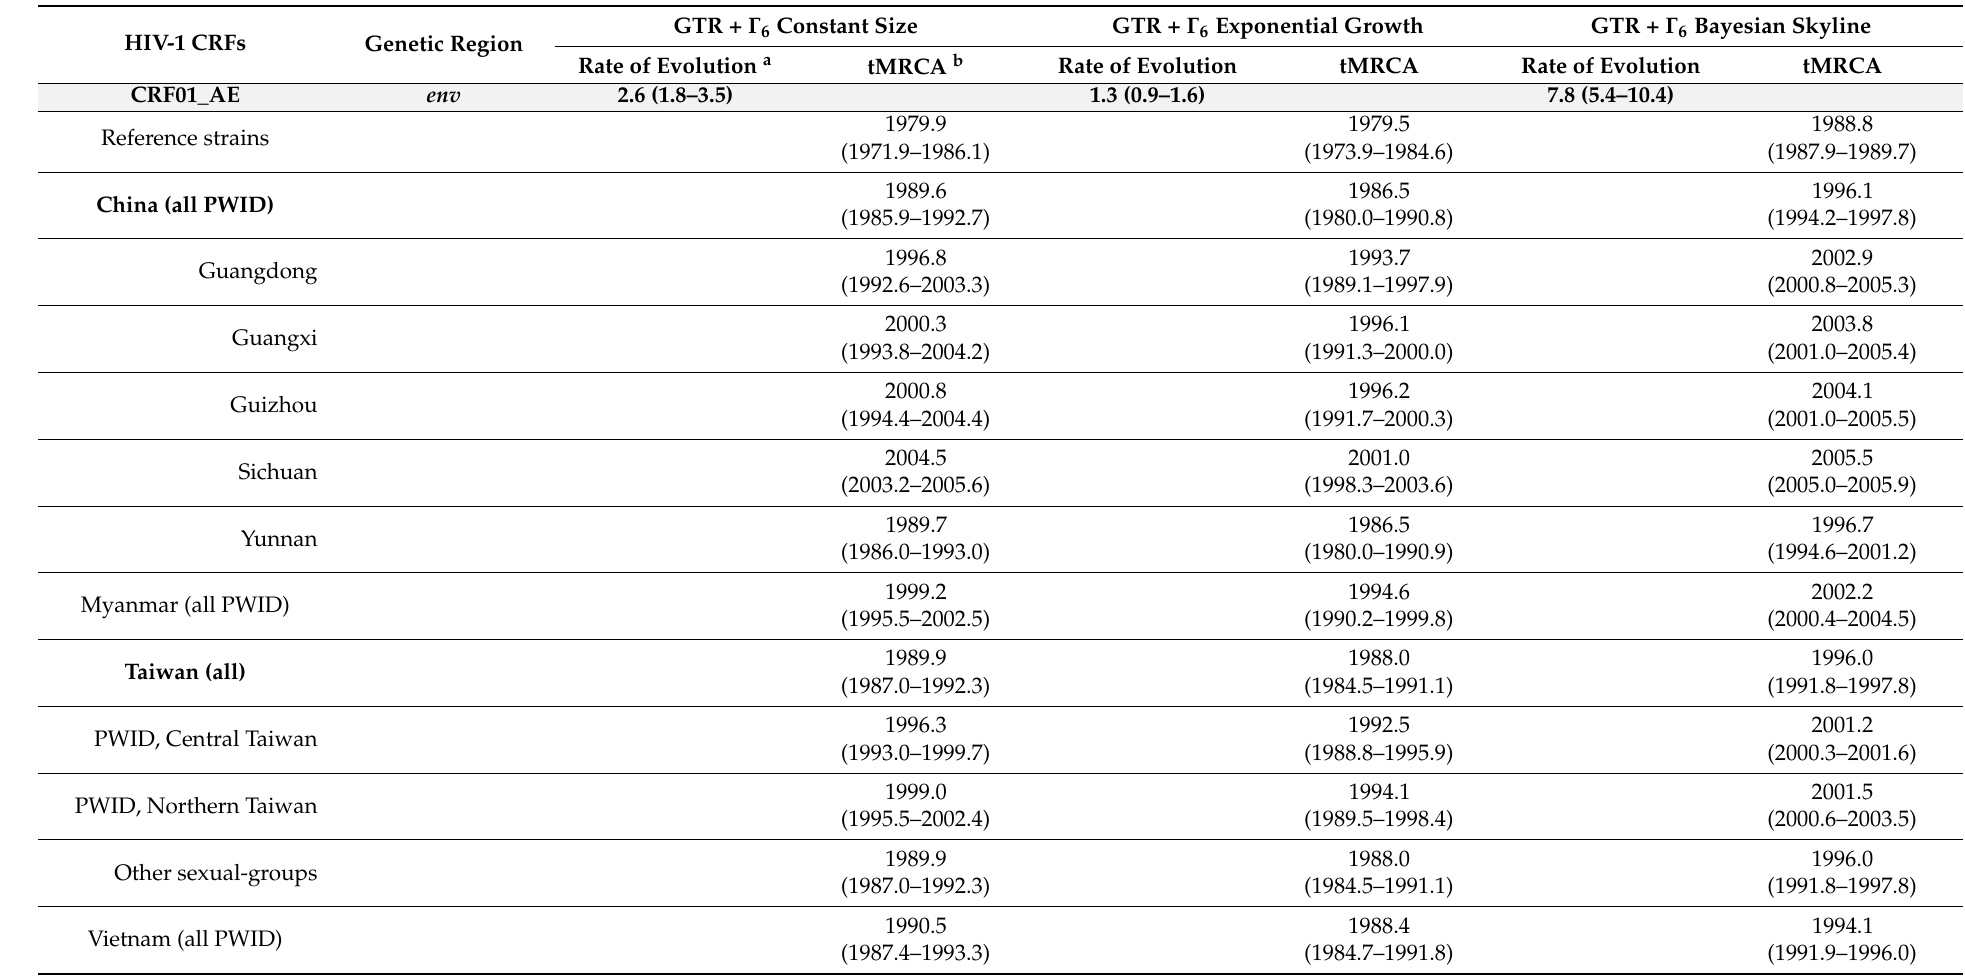
Table 1. Evolutionary characteristics of CRF01_AE and